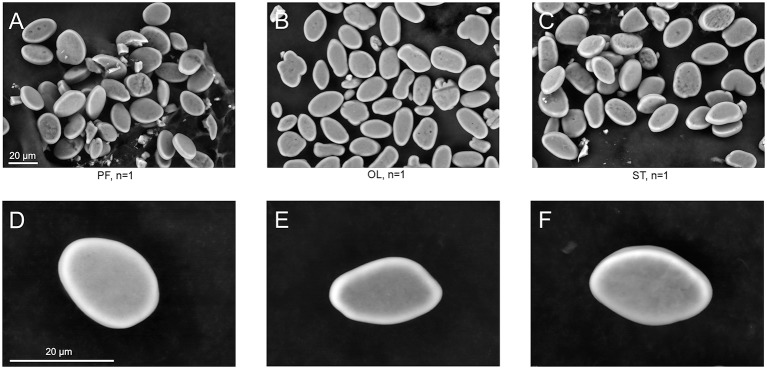
SEM images of statoconia. (A–C), Low magnification view used for area calculations; (D–F), Maximal magnification of typical statoconia. Columns represent statoconia preparations from different groups: (A,D), PF group; (B,E), OL group; (C,F), ST group.